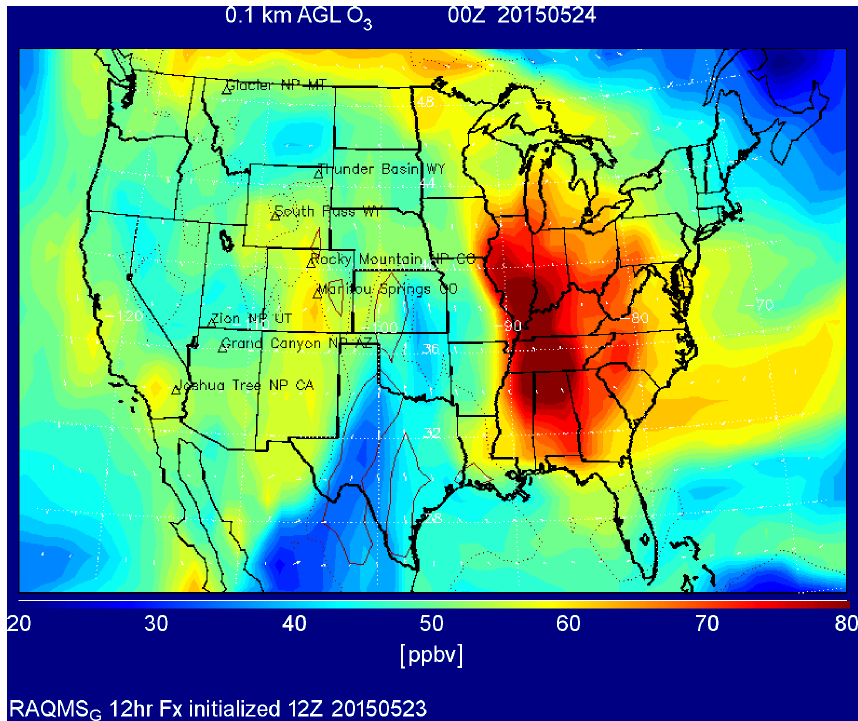
Figure 12. Ozone over the US on 24 May 2015 showing mixing ratios of more than 80ppb east of the Mississippi (RAQMS (Real-time Air Quality Modeling System) calculation kindly provided by Bradley Pierce (NOAA)).